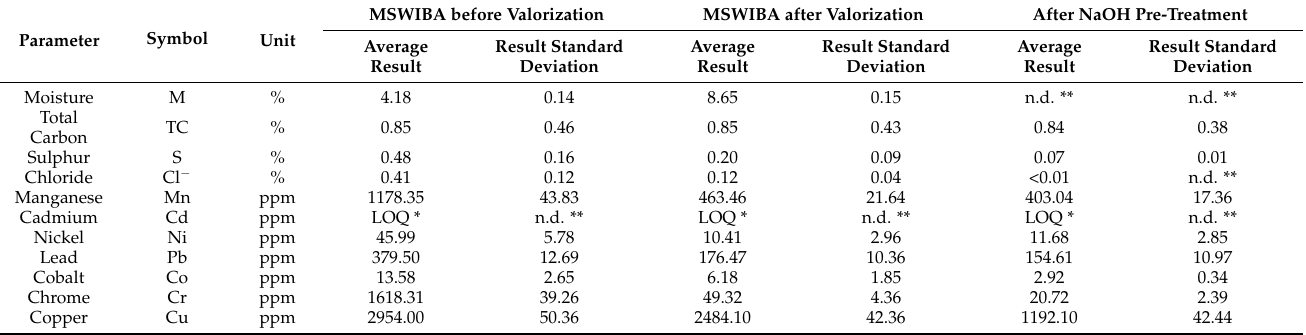
Table 2. Selected pollution in MSWIBA before and after valorization, and after the NaOH pre-